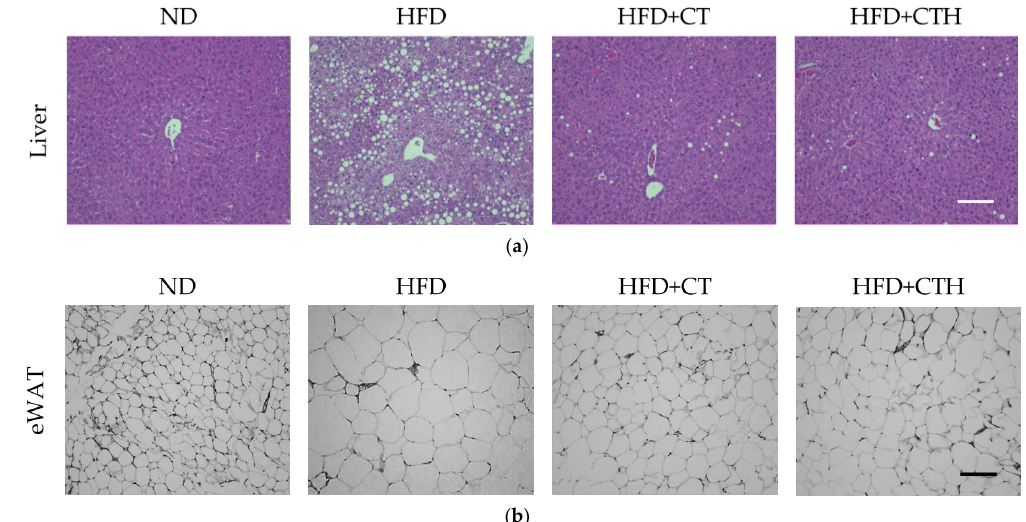
Figure 5. Results of hematoxylin and eosin stain. HE staining for ( a ) liver and ( b ) epididymal white adipose tissue (eWAT) (scale bar = 100 μm).